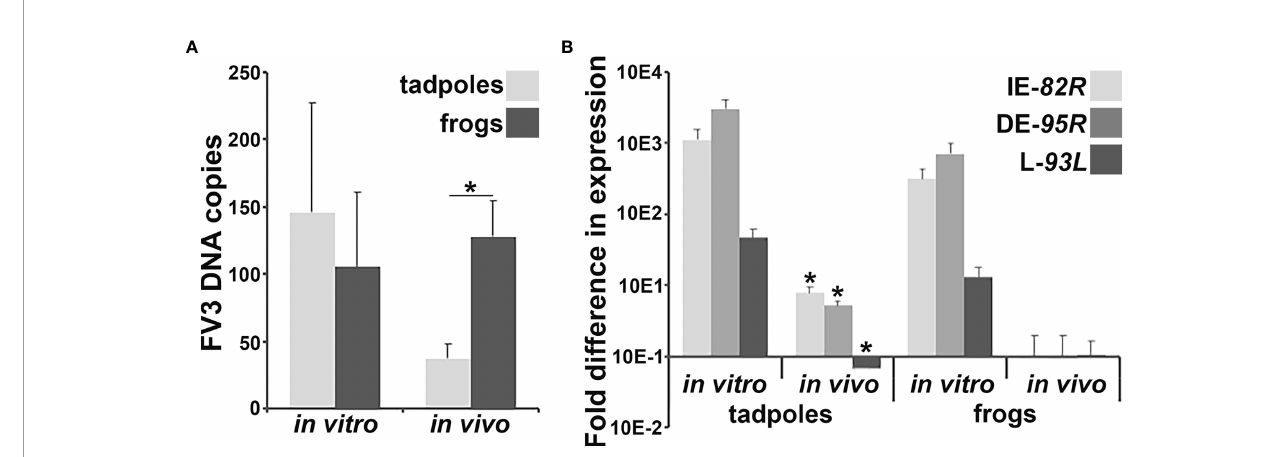
FIGURE 1 | Analyses of in vivo and in vitro FV3 DNA loads and gene expression in tadpole and adult frog intestines. Tadpoles ( N =6) and adult frogs ( N = 5) were infected by water bath with 10 6 PFU of FV3 for 6 hrs and their intestinal (A) FV3 loads and (B) FV3 gene expression examined. Alternatively, tadpole and adult frog intestinal cells ( N = 6) were infected in vitro with FV3 (0.5 MOI) and the (A) FV3 DNA loads and (B) expression of 82R (immediate early; IE), 95R (delayed early; DE) and 93L (late; L) FV3 genes, assessed by qPCR. The results are means ± SE of viral loads or viral gene expression. Asterisks above lines (*; A ) denote statistical differences between the treatment groups denoted by the line and asterisks (*; B ) denote statistically signi fi cant difference from in vitro expression, p <